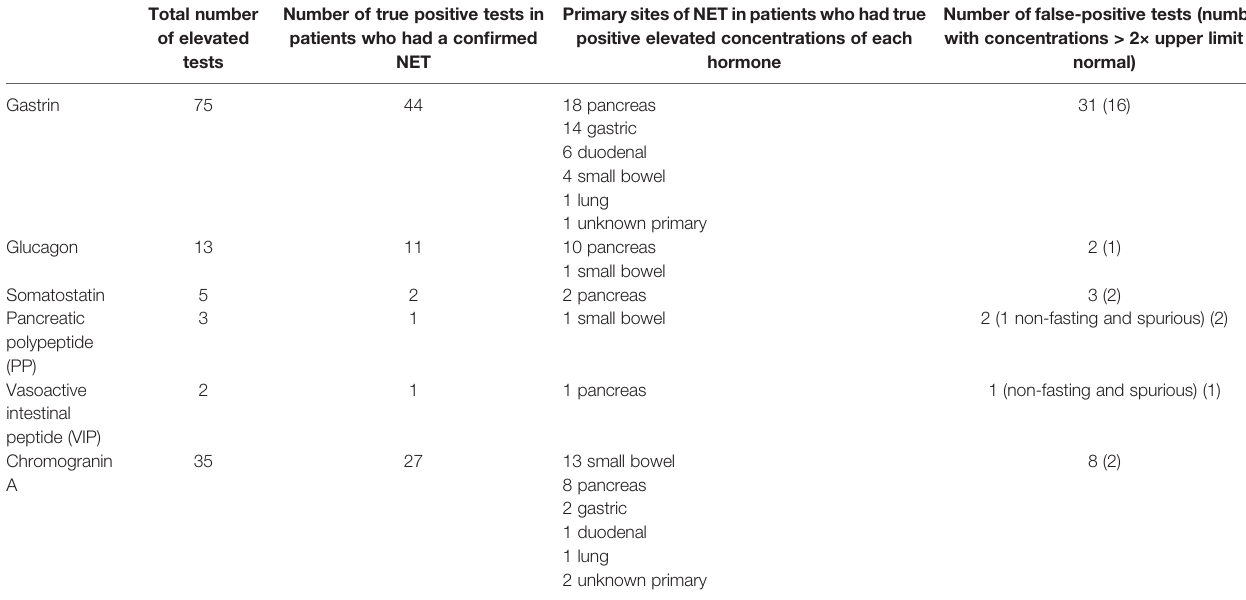
TABLE 1 | Association of elevated fasting gut hormone parameters with the presence of neuroendocrine tumor (NET). Total number of